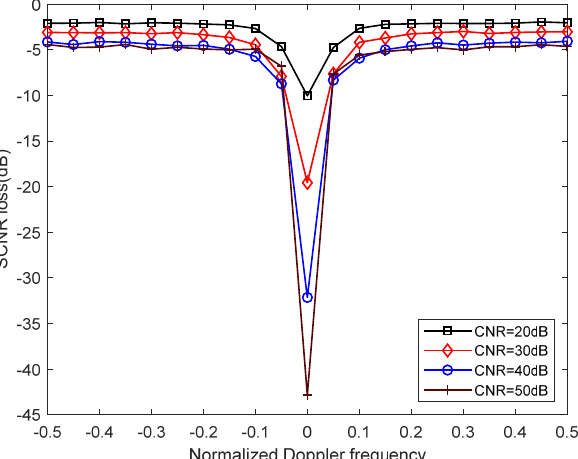
Figure 7. SCNR loss performance versus target Doppler frequency: with different clutter to noise ratio